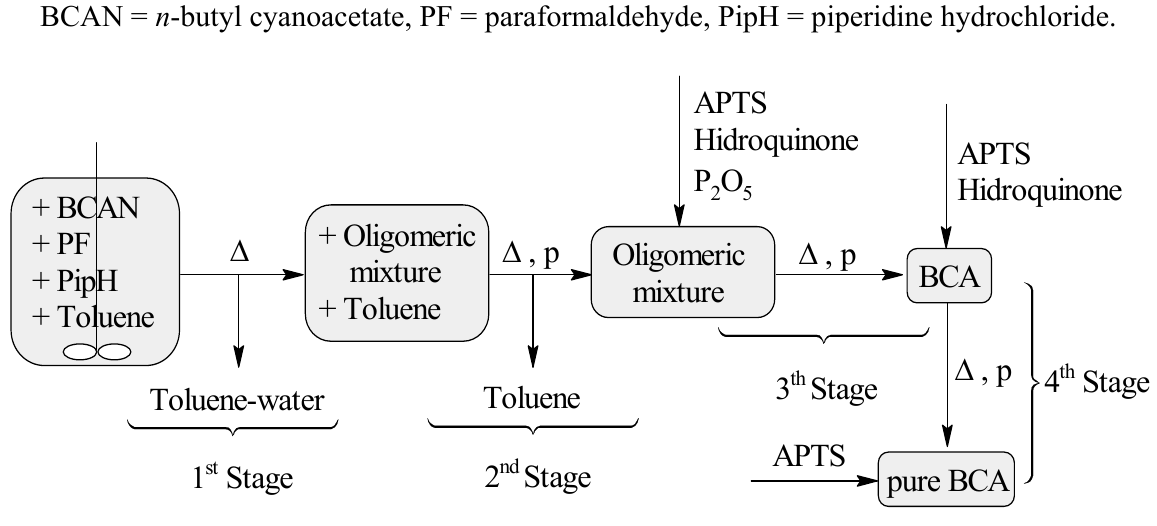
Figure 1. n -Butyl cyanoacrylate synthetic stage sequence when using oil bath heating ( ∆ ). BCAN = n -butyl cyanoacetate, PF = paraformaldehyde, PipH = piperidine